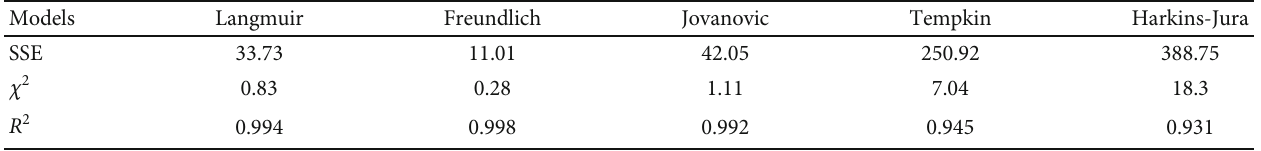
Table 5: Statistical parametric values for 2-parameter isotherms.